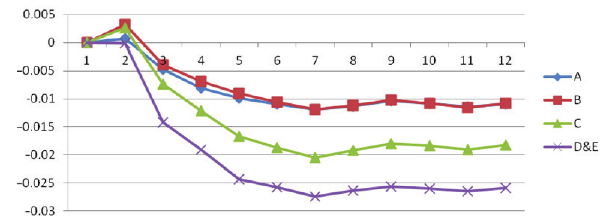
Figure 9f. Accumulated impulse response of PRI to shocks in Figure 9a. Accumulated impulse response of PRI to shocks in lagged PRI